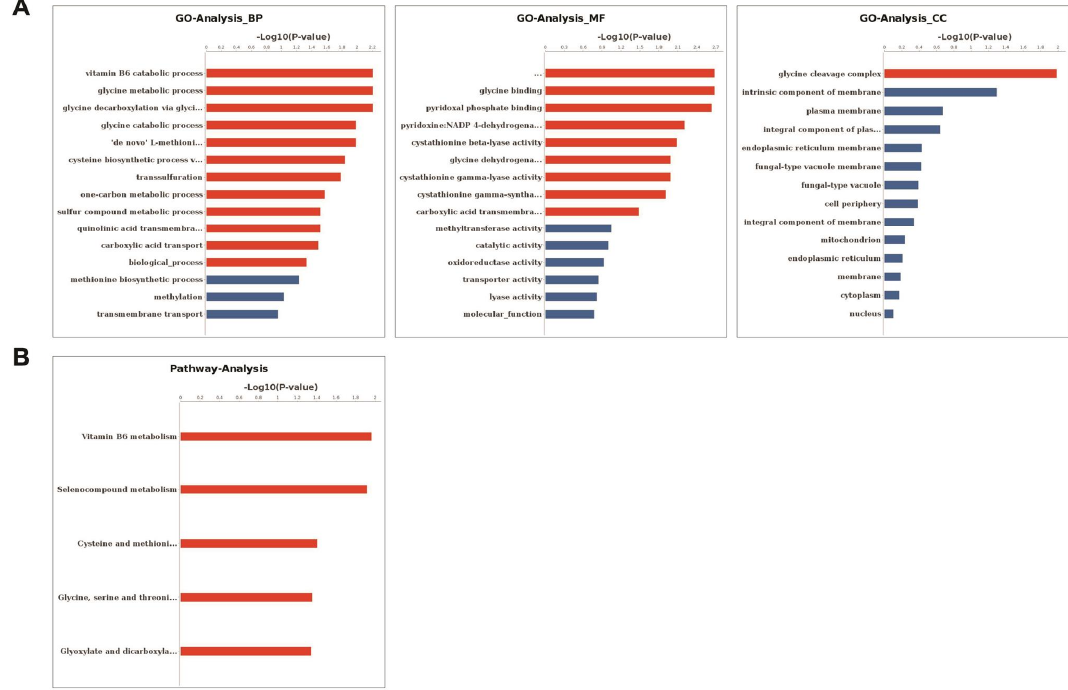
Figure 4. Function analysis of the di ff erentially expressed genes (DEGs). ( A ) Histogram of the gene ontology (GO) classification of the DEGs. Red color represents a significant term ( p < 0.05), and blue represents a non-significant term. ( B ) KEGG (Kyoto Encyclopedia of Genes and Genomes) annotation for the